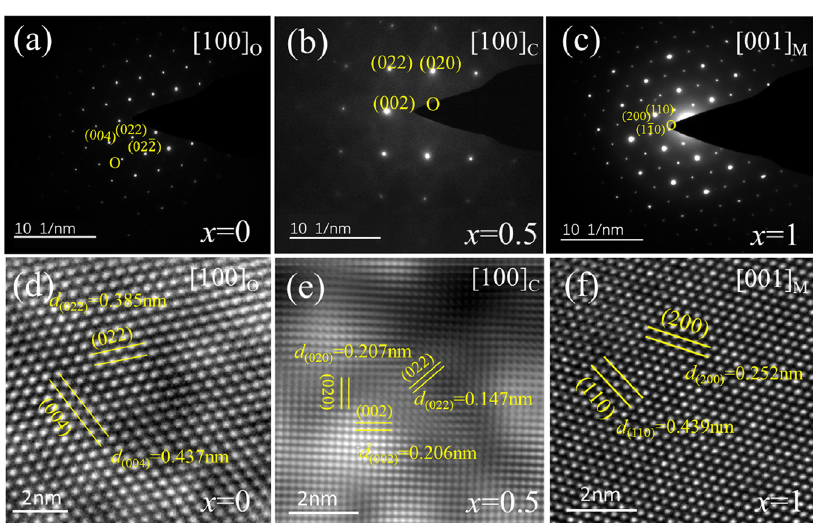
Fig. 13 Selected area electron diffraction (SAED) patterns of Li 3+ x Mg 2–2 x Nb 1– x Ti 2 x O 6 (0 ≤ x ≤ 1) ceramics for (a) x = 0 sample taken along [100] O zone a x is, (b) x = 0.5 sample along [100] C zone axis, and (c) x = 1 sample along [001] M zone axis. (d − f) Corresponding high resolution transmission electron microscopy (HRTEM) images of the selected areas of the above samples. Reproduced with permission from Ref. [247], © Elsevier Ltd and Techna Group S.r.l. 2020.